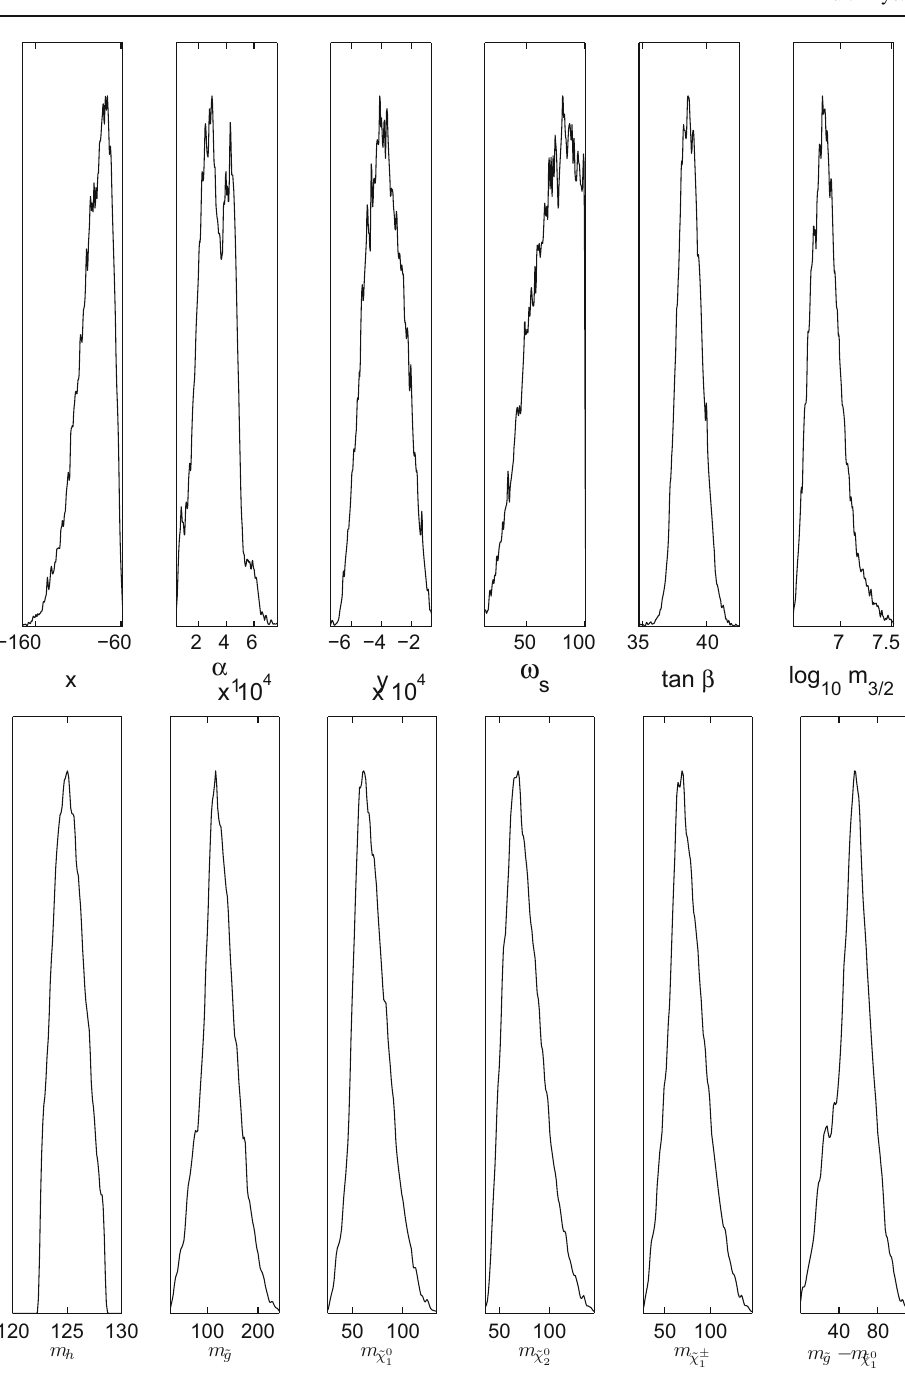
(not shown here) are all of the order of 10 TeV. The vertical axis is a measure of the relative posterior probabilities between the x -axis points